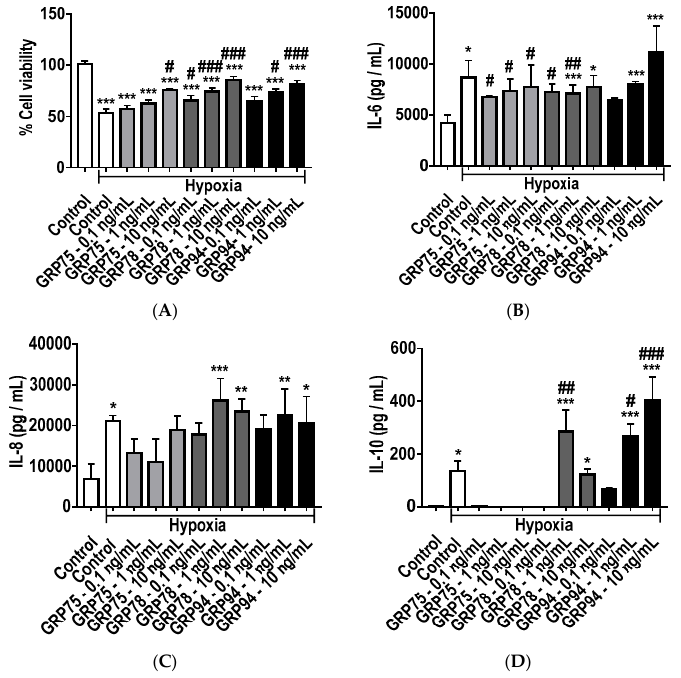
Figure 7. ( A ) Cell viability and release of pro-inflammatory ( B ) IL-6, ( C ) IL-8 and anti-inflammatory ( D ) IL-10 cytokines from A549 cells treated with recombinant glucose-regulated proteins (GRP75, GRP78 and GRP94) treatment during hypoxic (0.5% O 2 ) exposure for 24 h. ELISAs were used to measure secreted cytokines in the supernatant of A549 cells. Data presented as mean ± SD; n = 3 (* p < 0.05, ** p < 0.01, *** p < 0.001 vs. normoxia control; and # p < 0.05. ## p < 0.01, ### p < 0.001 vs. hypoxia control). The resulting data were statistically analysed using one-way ANOVA and